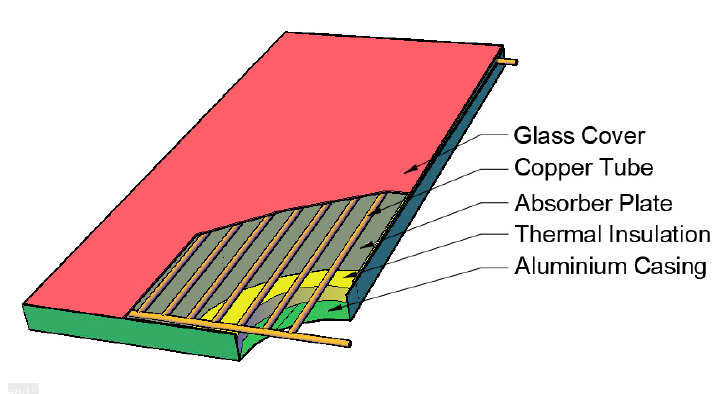
Figure 1. The structure of a flat plate collector.